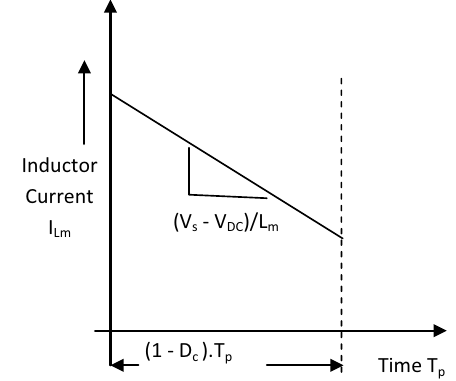
D c ).T p ) interval −